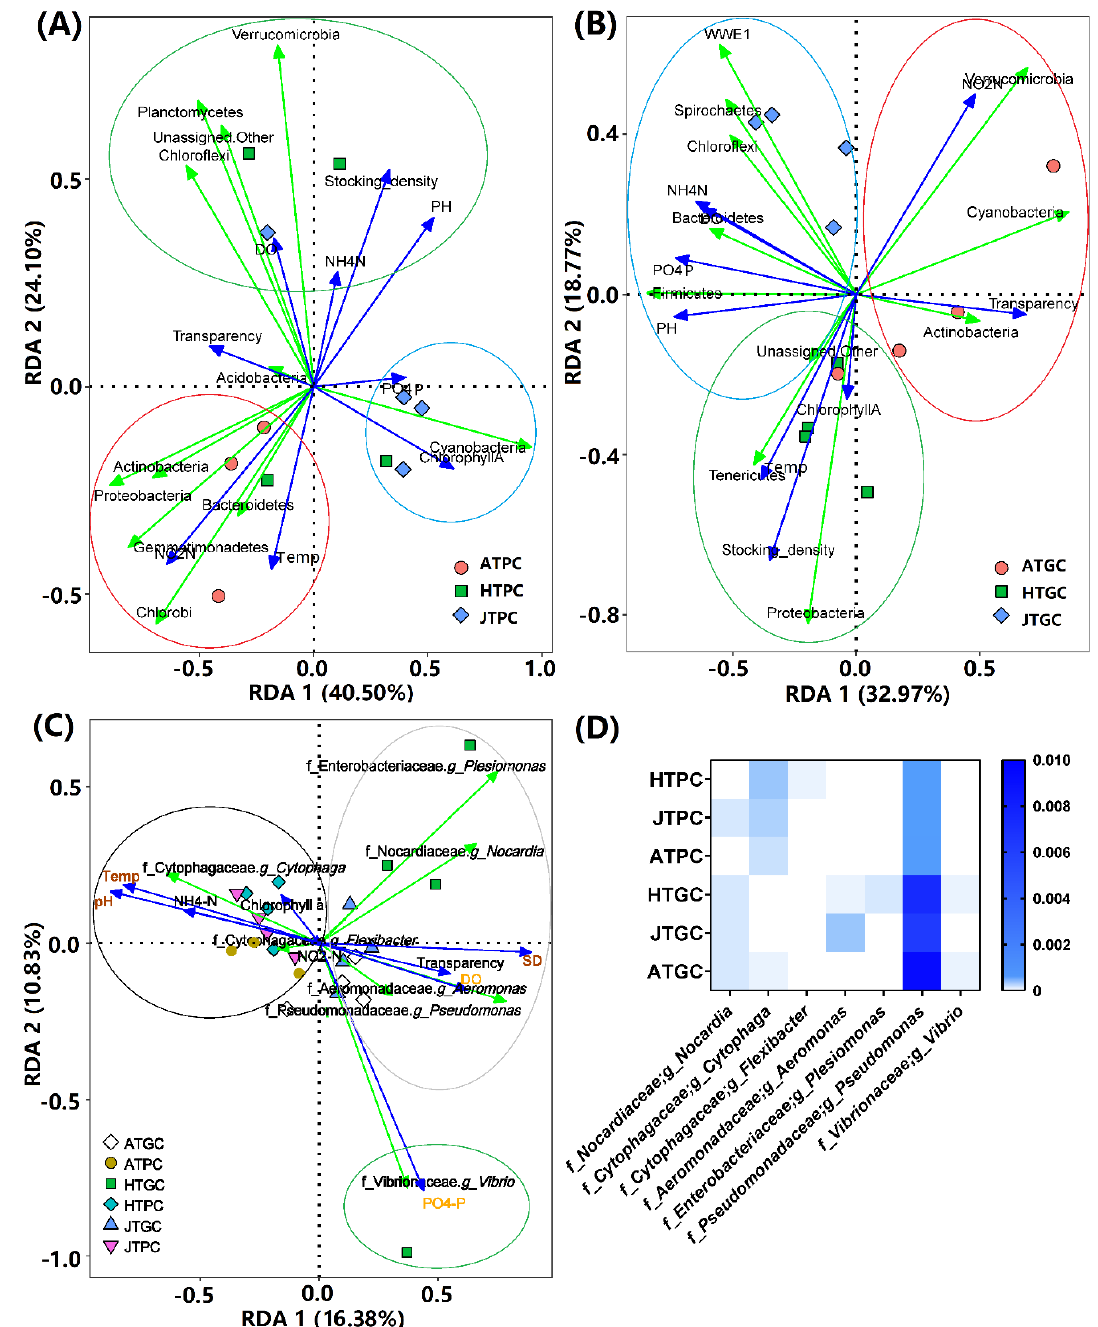
Figure 6. Correlation analysis of environmental factors of PC and GC groups. ( A , B ) Redundancy analysis (RDAs) of PC and GC groups based on OTUs of 16S rRNA genes. ( C ): RDA analysis of PC and GC groups based on potential pathogenic bacteria. The blue arrows above represent different environmental factors, and the green arrows represent different phylum of microbiota (top10) and different genus of potential pathogenic bacteria. The arrow length of the environmental factor represents the correlation magnitude between the environmental factors and the samples, and longer arrows represent greater influence on the distribution of the samples and microbiota. The angle between the lines of the arrows represents the correlation. The acute angle indicates that the two environmental factors are positively correlated, and the obtuse angle is negatively correlated. The value in the ( D ) represent the abundance of potential pathogenic bacteria in PC and GC groups.